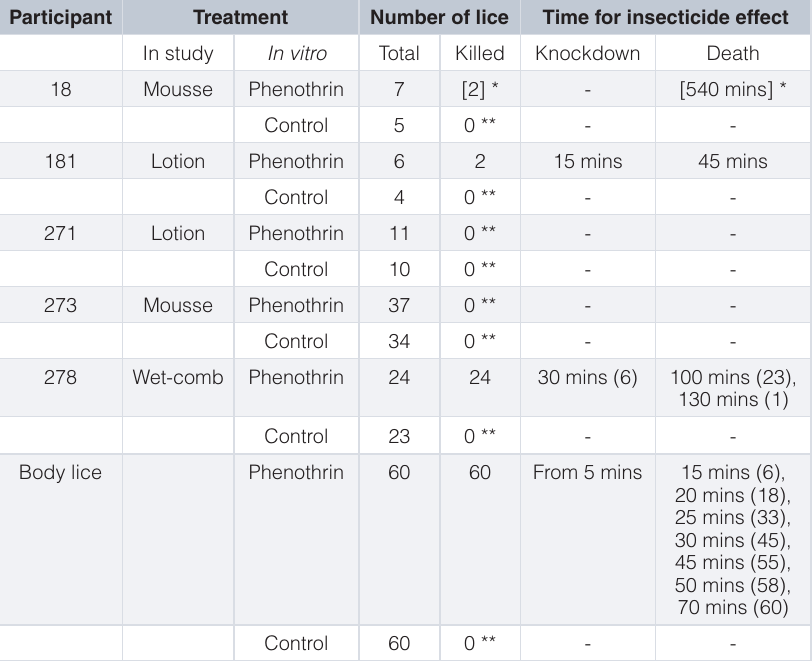
Table 2. Sensitivity of head lice from study participants to d -phenothrin in vitro